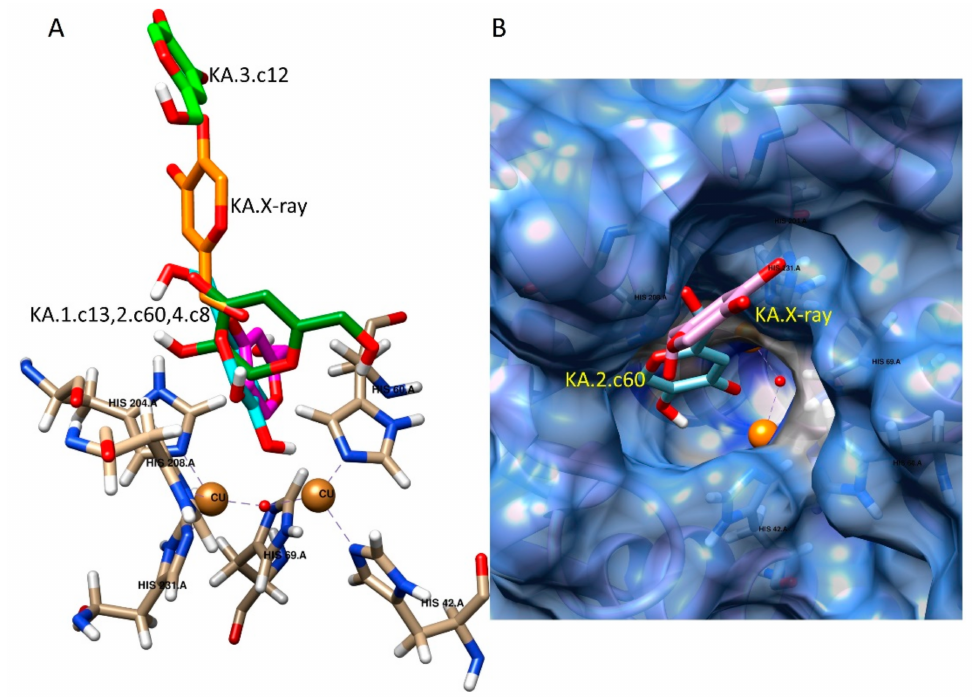
Figure 5. Representation of the catalytic site of B. megaterium tyrosinase in presence of kojic acid (KA) (PDB file 3NQ1). ( A ) Copper ions (orange balls), kojic acid in X-ray (orange), the best docking poses of kojic acid (magenta, green and pink), the six hystidines (turquois) coordinated to the copper ions. The red sphere represents a molecule of water. ( B ) The entrance of the catalytic site. KA in the X-ray structure (orange) and the best scoring position (violet). Copper ions (orange balls) and molecule of water (red